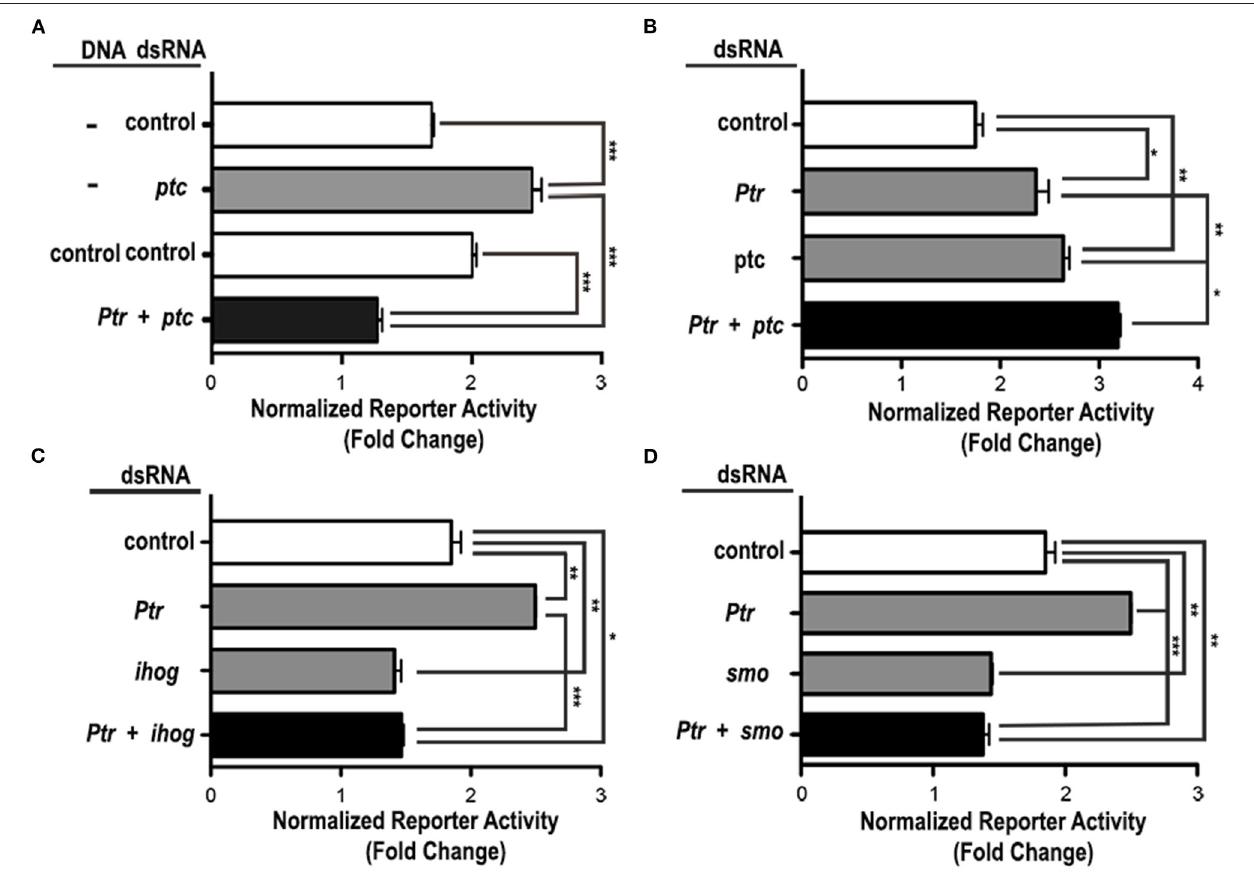
FIGURE 5 | Ptr functions downstream or at the same level as Ptc in the Hh signaling cascade. (A) The enhanced response to the Hh signal caused by the knockdown of ptc can be suppressed by the co-transfection of a vector that expresses Ptr. dsRNAs targeting the B. subtilis lys gene and a construct for expression of GFP serve as controls. (B) The co-transfection of Ptr and ptc dsRNA produced an activation of the signaling pathway that was stronger than the activation obtained by the independent knockdown of each gene. Ptr functions seem to act independently on (C) iHog or (D) Smo. The transfection of Ptr dsRNA does not affect the activation level of the Hh pathway resulting from the knockdown of ihog or smo genes. In all the graphics, white bars are negative controls, gray bars are internal controls for the dsRNA and vector transfected, and black bars are the experimental condition for each set of experiments. Data are presented as mean ± SEM, n = 3 per group. Analysis was performed using one-way ANOVA with the Tukey post-hoc tests, * p < 0.05, ** p < 0.01 and *** p < 0.001.